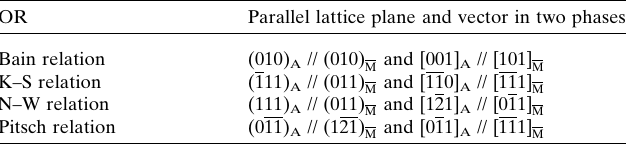
Table 2 Plane and direction parallelisms defined by the four ORs adapted to the structure of the austenite and the average structure of the present martensite.